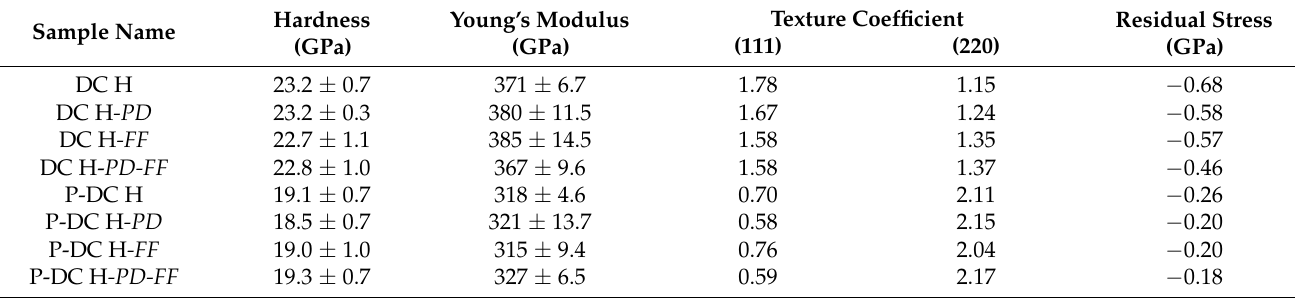
Table 4. Mechanical properties of TiN created using various HiPIMS operating modes under DC or P-DC bias.